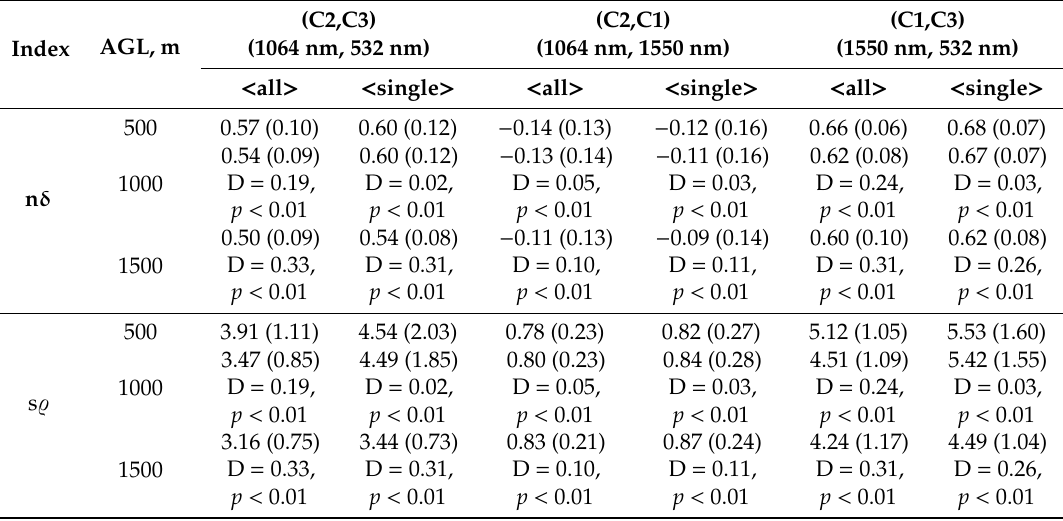
Table 6. The mean values and standard deviation (in brackets) for n δ and s (cid:37) for the whole AOI at three altitudes, derived from all returns and from single returns. P -values and D-statistics from Kolmogorov-Smirnov test are given for comparisons of 500 m products to 1000 m products, and 1500 m products. All p -values are low because of the large sample size (~80,000) and D-statistics provide values of practical significance for